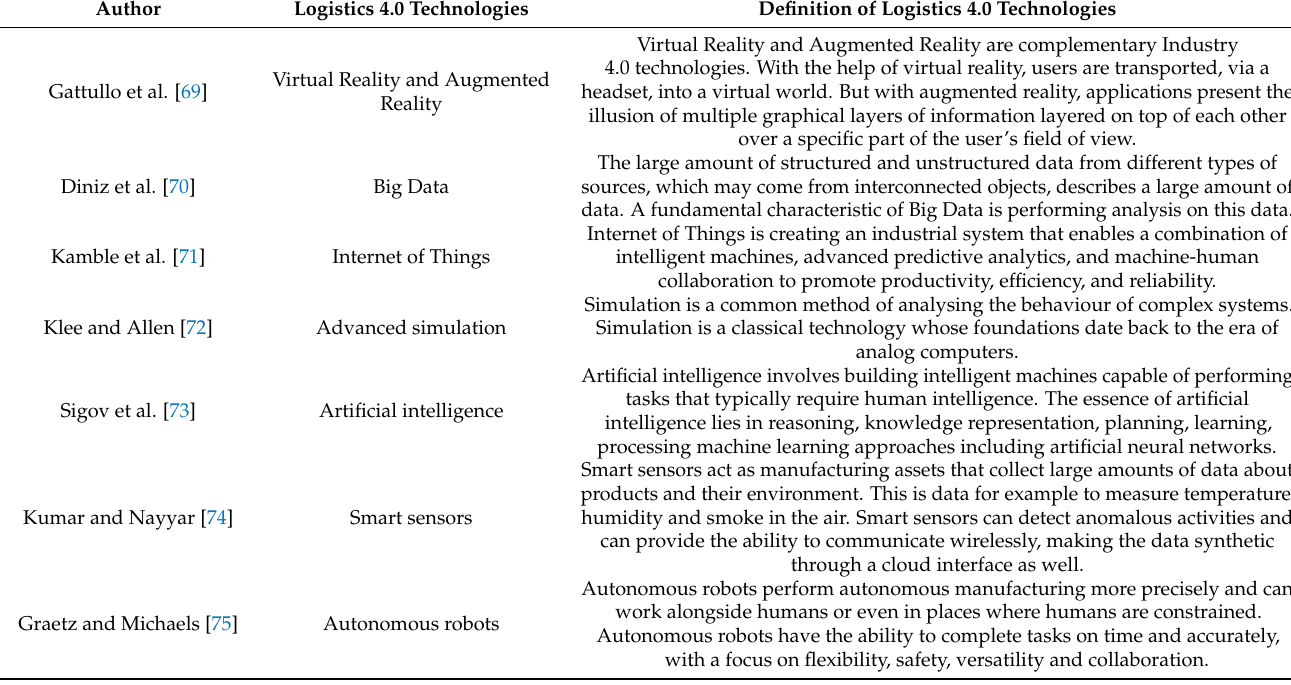
Table 2. Definition of Logistics 4.0